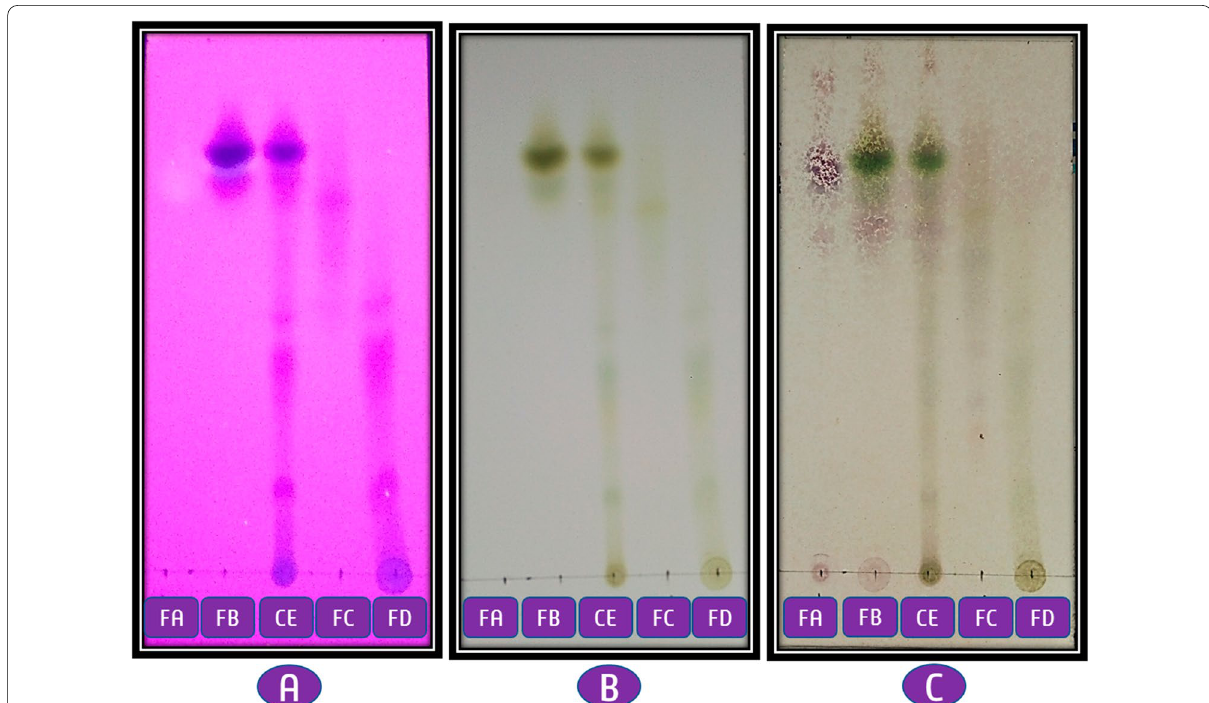
Fig. 1 TLC profiles of fractions (FA-FD) obtained from chloroform extract (CE) of Vernonia amygdalina leaf. A Profile at 365 nm under UV light; B Profile in daylight; C Profile after spraying with vanillin-H 2 SO 4 reagent and heating plate in the oven at 105 °C for 5 min; mobile phase: EtOAc/MeOH (90/10)